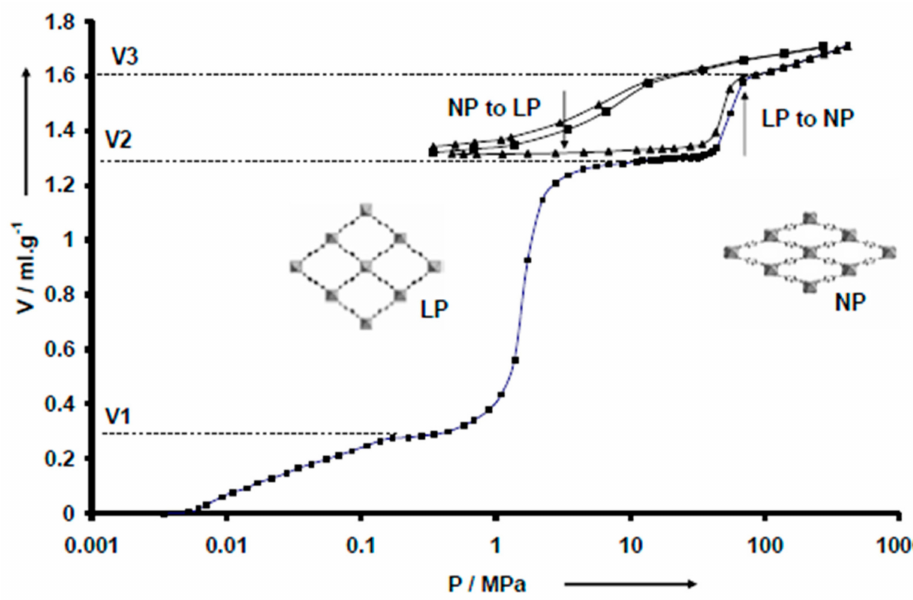
Figure 2. Large pores (LP) to narrow pores (NP) transition in MIL-53(Cr) sample upon intrusion–extrusion of mercury: cumulative intruded volume versus applied pressure. The arrows show the steps that correspond to the LP to NP transition. Squares: first intrusion–extrusion cycle. Triangles: second intrusion–extrusion cycle